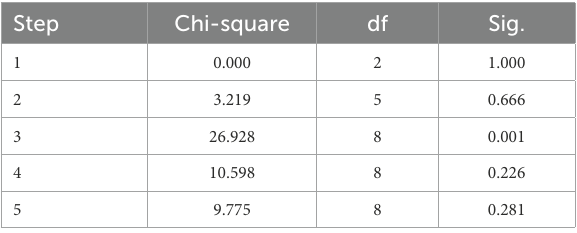
TABLE 6 Hosmer and Lemeshow test (Forward: LR).